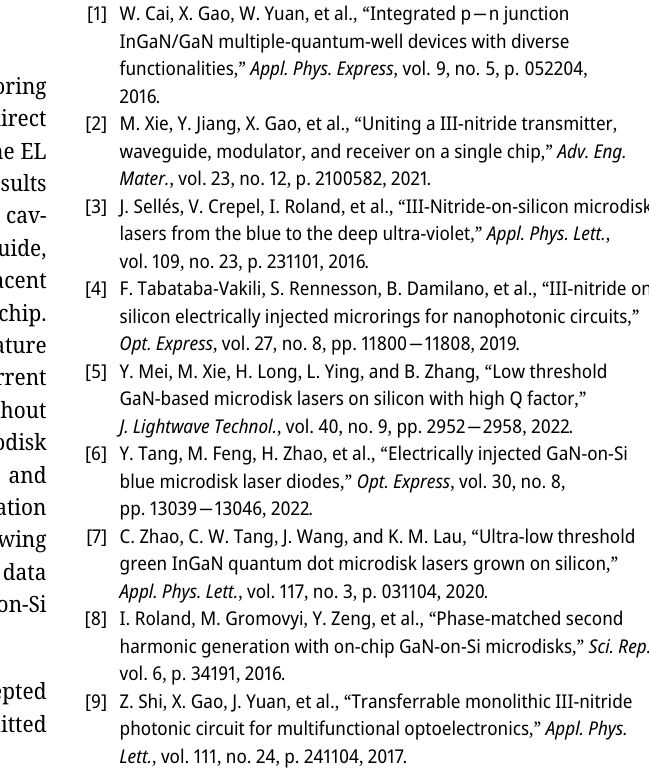
surface plasmon-enhanced effect and hence optical con- finement is underway to improve the device performance [36,